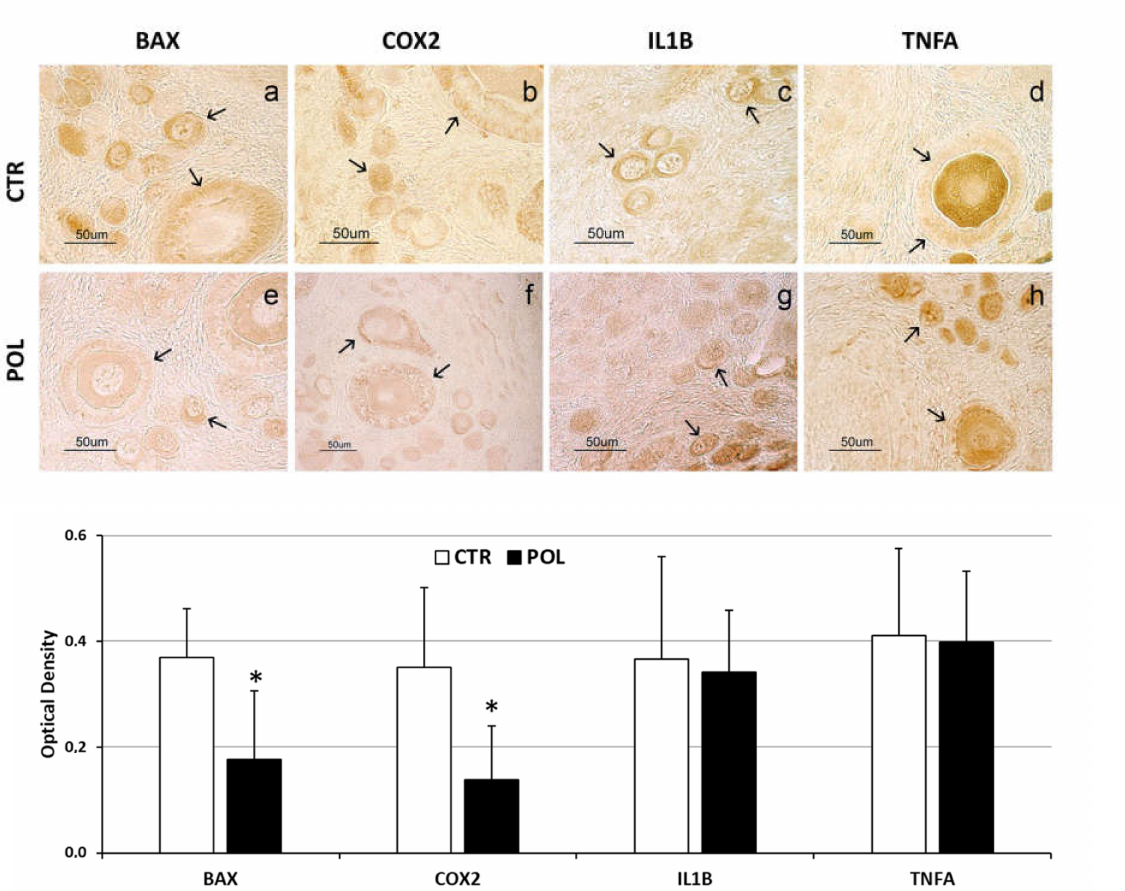
Figure 2. Immunohistochemistry in ovary tissue sections of rabbits fed with a commercial pellet alone (CTR) or supple- mented with an olive mill waste water product to reach a total concentration of 282.4 mg/kg of phenolic compounds (POL). Upper panel: immunohistochemical reactivity for BAX ( a , e ), COX2 ( b , f ), IL1B ( c , g ), TNFA ( d , h ). DAB staining is evident in the cytoplasm of primordial, primary follicular cells (arrows) and some egg cells (asterisk) of both groups (for more details see the text). Lower panel: intensity of staining expressed as average optical density. Data represent the mean ± SD of 10 replicates. Kruskal–Wallis test: * p < 0.05 CTR vs. POL (BAX: p = 0.0018; COX2: p = 0.0027; IL1B: p = 0.7258; TNFA: p = 0.8509). Levene’s test: BAX: p = 0.4304; COX2: p = 0.5202; IL1B: p = 0.7963; TNFA: p =